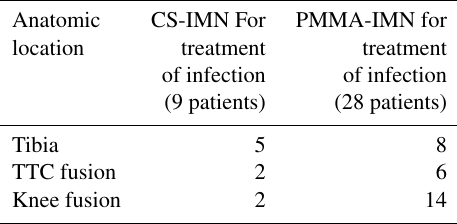
Table 2. Anatomic location of septic complex lower extremity re- construction in the active infection treatment groups.